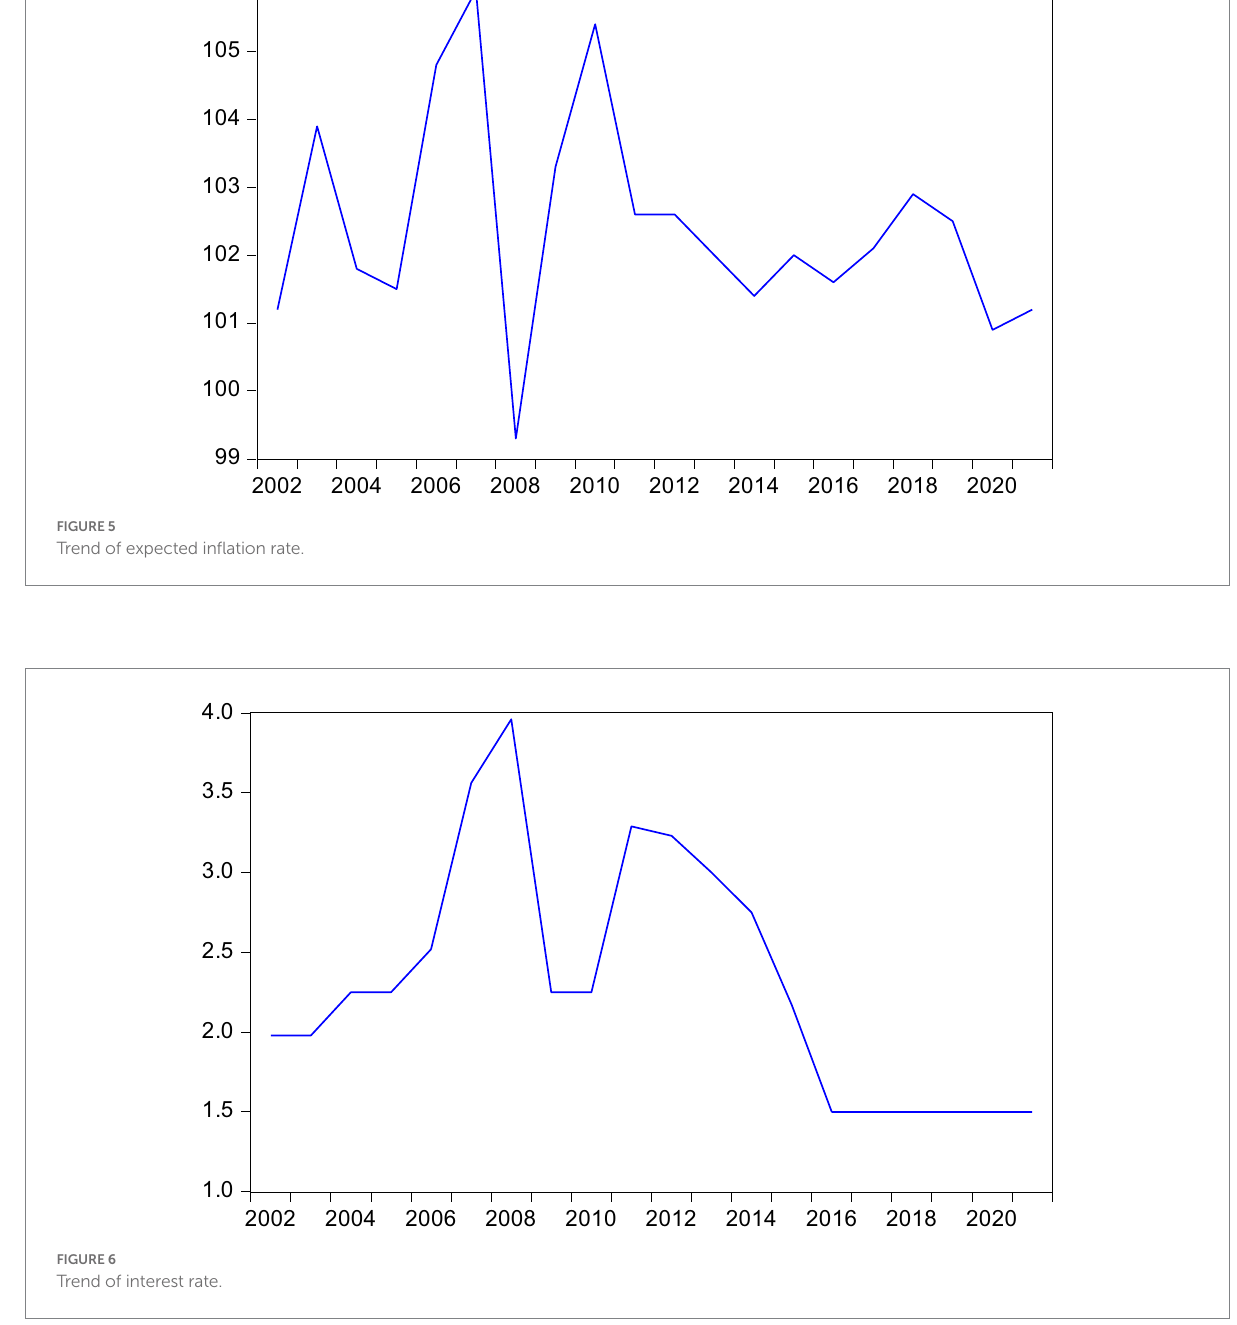
FIGURE 6 Trend of interest